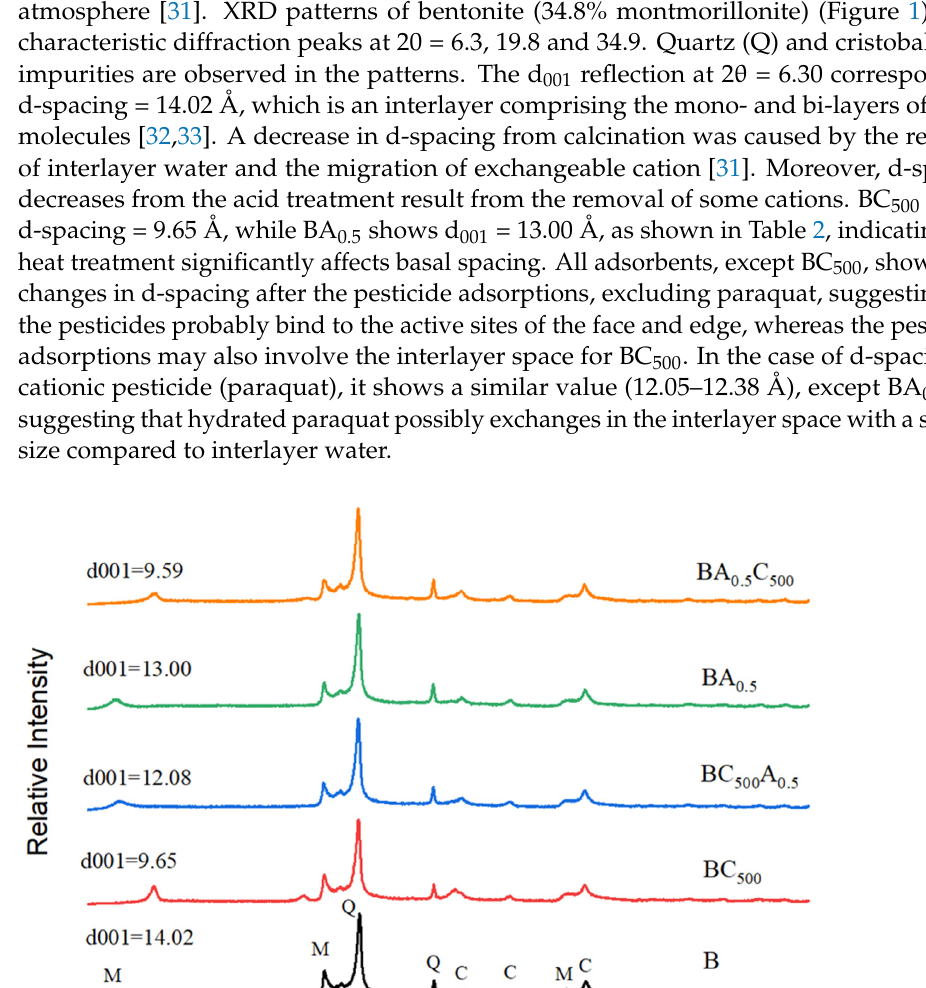
Table 1. Chemical composition and CEC values for bentonite and modified bentonite samples.